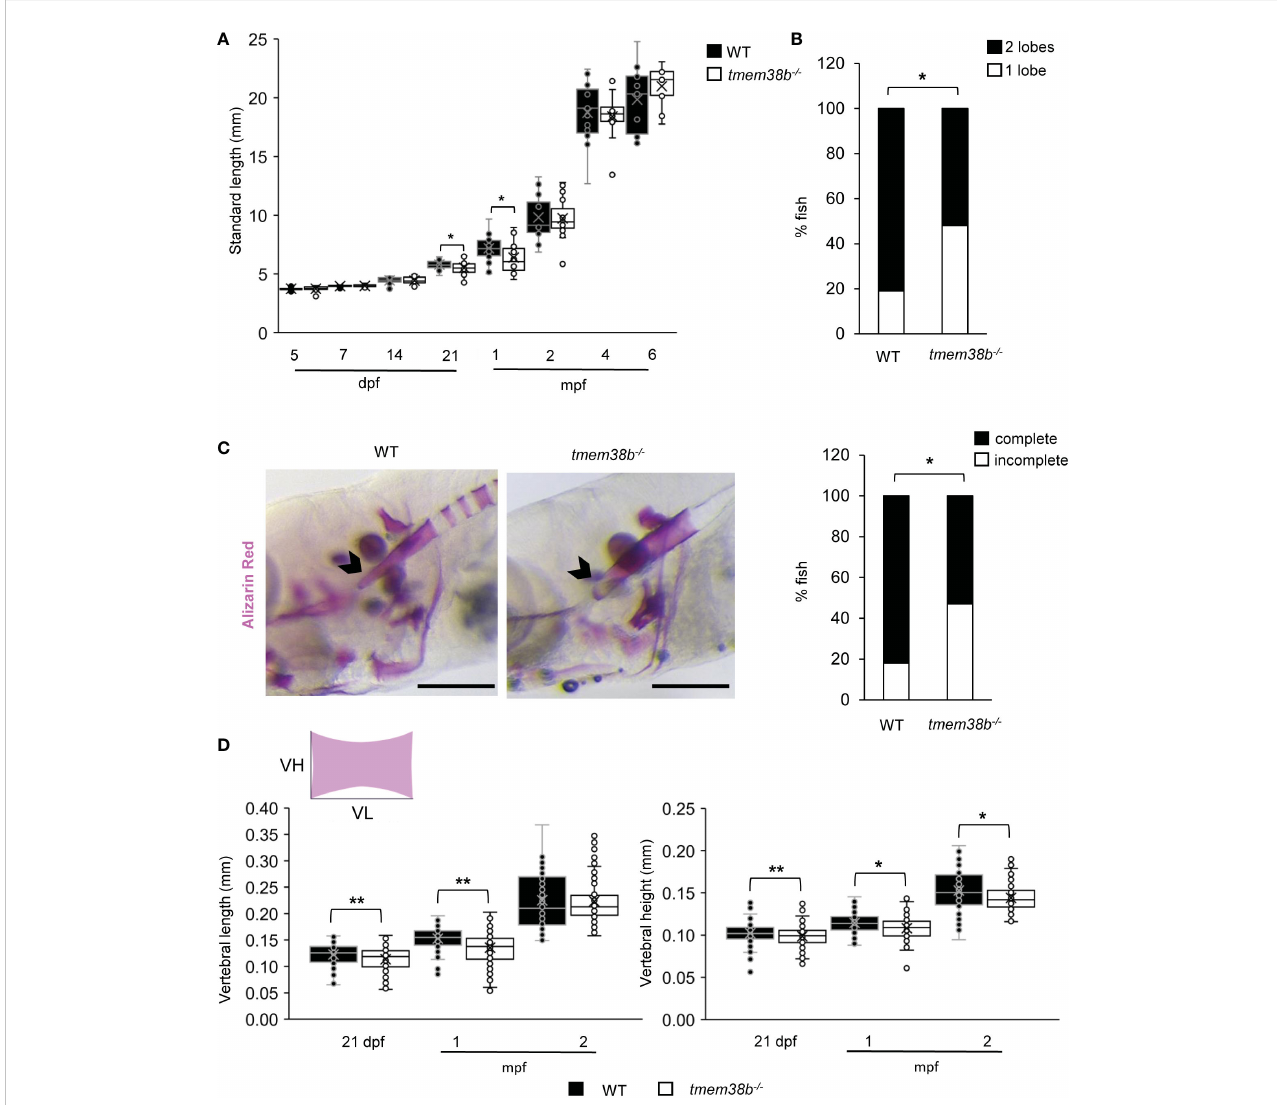
FIGURE 3 tmem38b -/- skeletal phenotype. (A) Growth curves representing WT and tmem38b -/- standard length measured at 5, 7, 14, 21 dpf, 1, 2, 4 and 6 mpf. At 21 dpf and 1 mpf tmem38b -/- were signi fi cantly shorter than WT. WT n ≥ 13, tmem38b -/- n ≥ 8. (B) At 21 dpf a signi fi cant delay in the in fl ation of the swim bladder was observed in tmem38b -/- (n = 27) with respect to WT (n = 28). (C) Representative lateral view (left panels) of 14 dpf alizarin red stained WT and tmem38b -/- fi sh. The notochord is indicated by the arrowhead. On the right the graph represents the level of the tip of the notochord mineralization, a delayed mineralization was evident in tmem38b -/- ( tmem38b -/- n = 17) respect to WT (WT n = 28) Scale bar: 500 µm. (D) Vertebral length and vertebral height measurement in WT and tmem38b -/- zebra fi sh. Vertebral length (VL) was reduced in tmem38b -/- compared to WT at 21 dpf and 1 mpf. Vertebral height (VH) was reduced in tmem38b -/- compared to WT at 21 dpf, 1 and 2 mpf. 21 dpf: WT n= 29; tmem38b -/- n= 25; 1 mpf: WT n= 24; tmem38b -/- n= 18; 2 mpf: WT n= 13; tmem38b -/- n= 14. *,p < 0.05, **p ≤